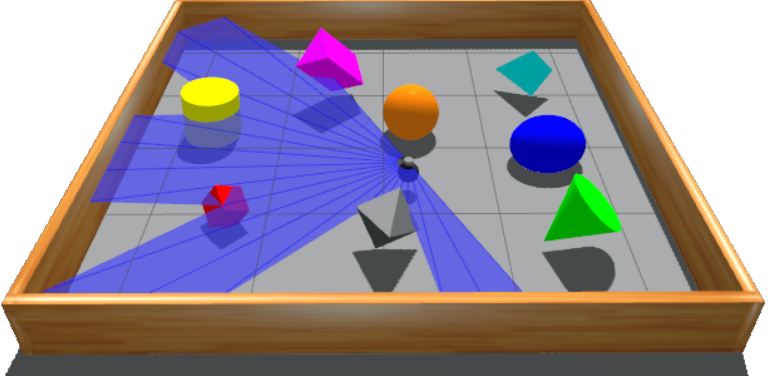
Figure 4. Training map, where obstacles in different shapes, sizes, and postures were randomly placed in each training episode so as to randomize the training